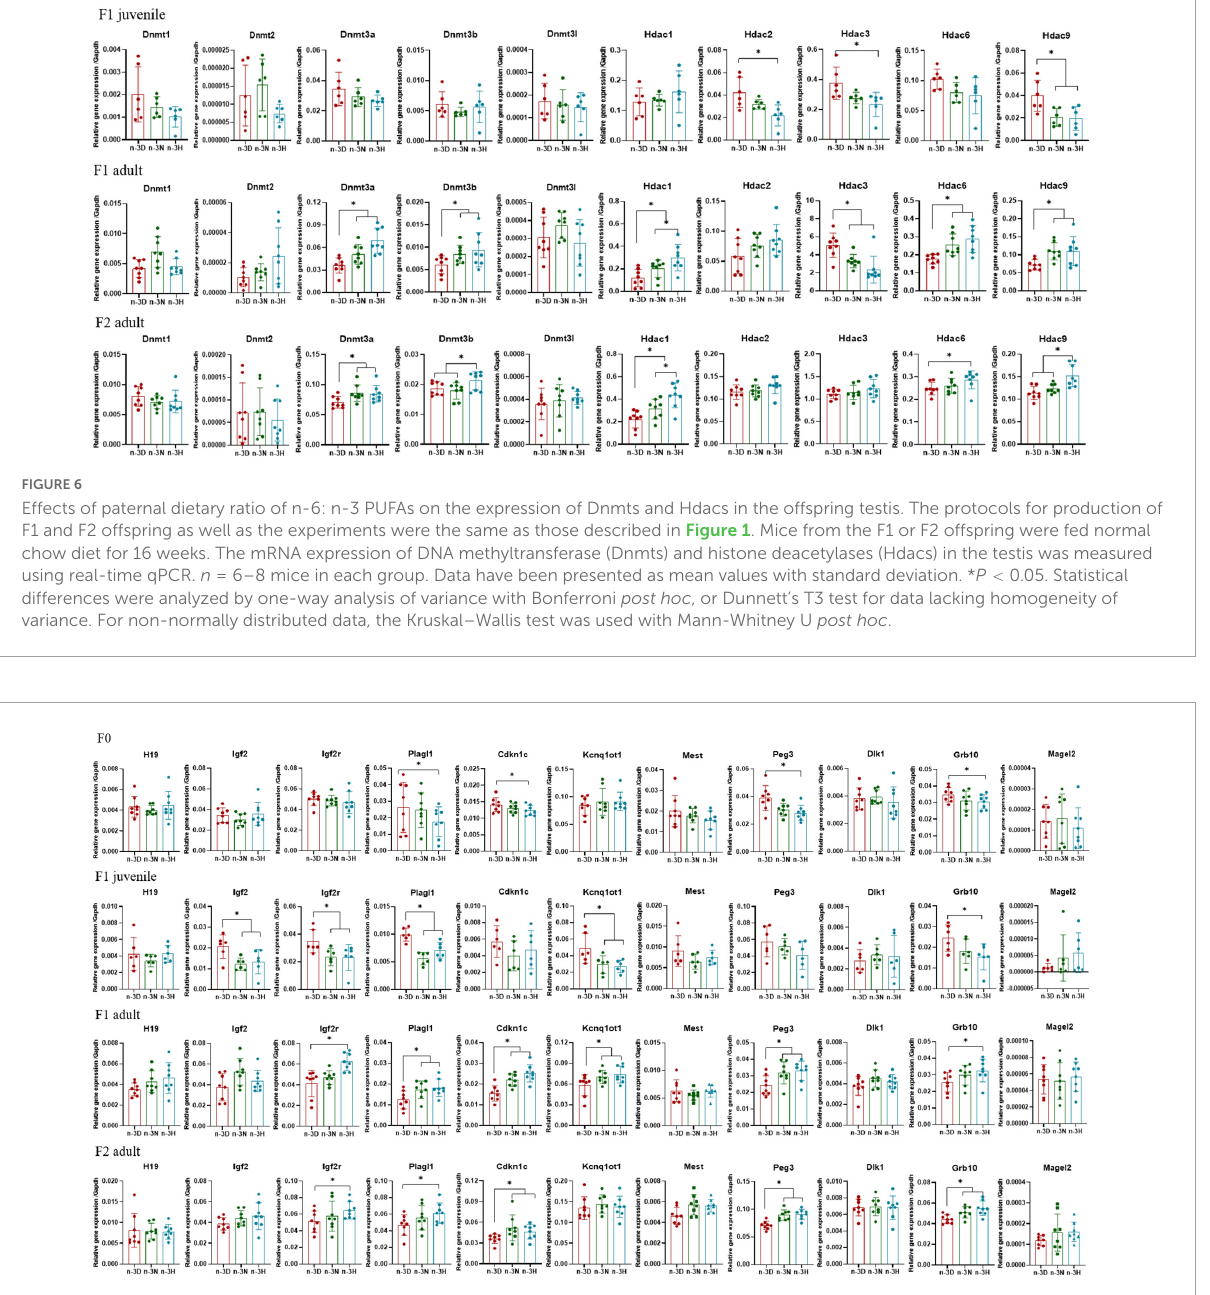
FIGURE7 Effects of paternal dietary ratio of n-6: n-3 PUFAs on the expression of imprinted genes in the offspring testis. The protocols for production of F1 and F2 offspring as well as the experiments were the same as those described in Figure 1 . Mice from the F1 or F2 offspring were fed normal chow diet for 16 weeks. The mRNA expression of the imprinted genes in the testis was measured using real-time qPCR. n = 6–8 mice in each group. Data have been presented as mean values with standard deviation. * P < 0.05. Statistical differences were analyzed by one-way analysis of variance with Bonferroni post hoc . For non-normally distributed data, the Kruskal–Wallis test was used with Mann-Whitney U post hoc